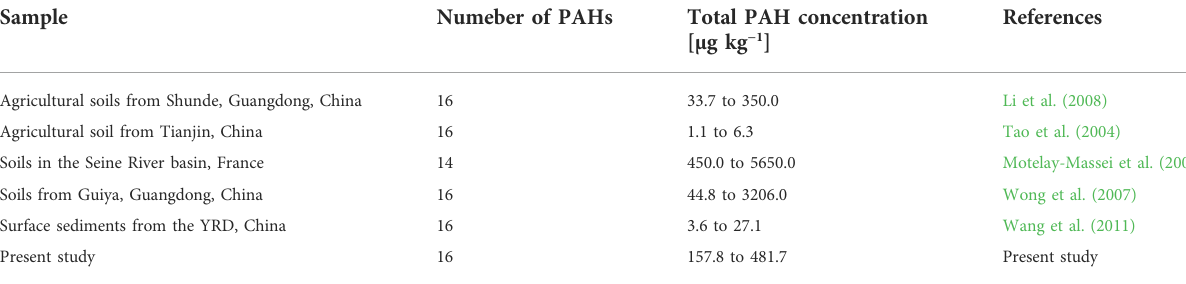
TABLE 2 Total PAH concentrations in soil samples reported in previous literature.